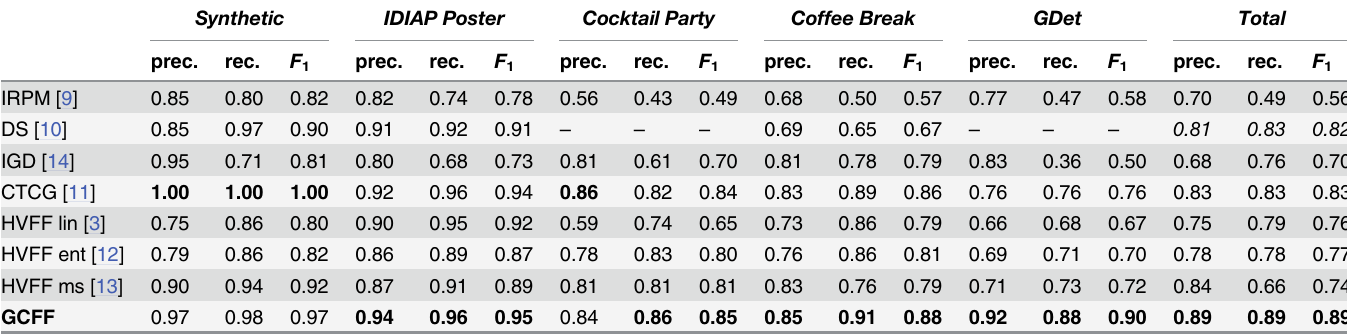
Table 5. Average precision, recall and F 1 scores for all the methods and all the datasets ( T = 2/3). Please note that DS results are averaged over only 3 datasets and thus cannot be taken into account for a fair comparison. Synthetic IDIAP Poster Cocktail Party Coffee Break GDet Total